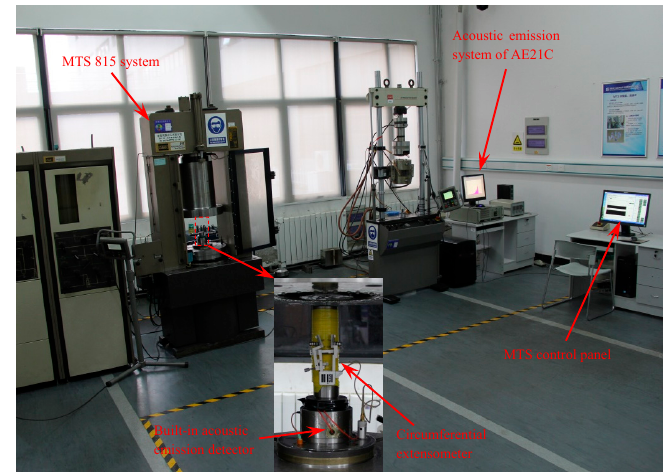
Figure 3. MTS815 and AE21C experimental systems.